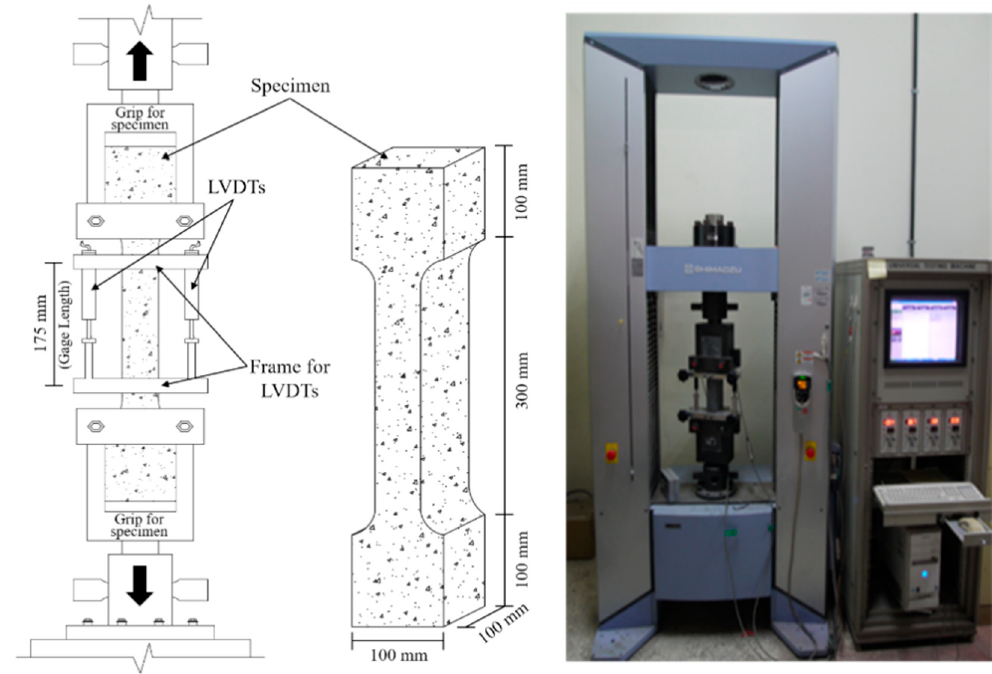
Figure 1. Direct tensile strength test.